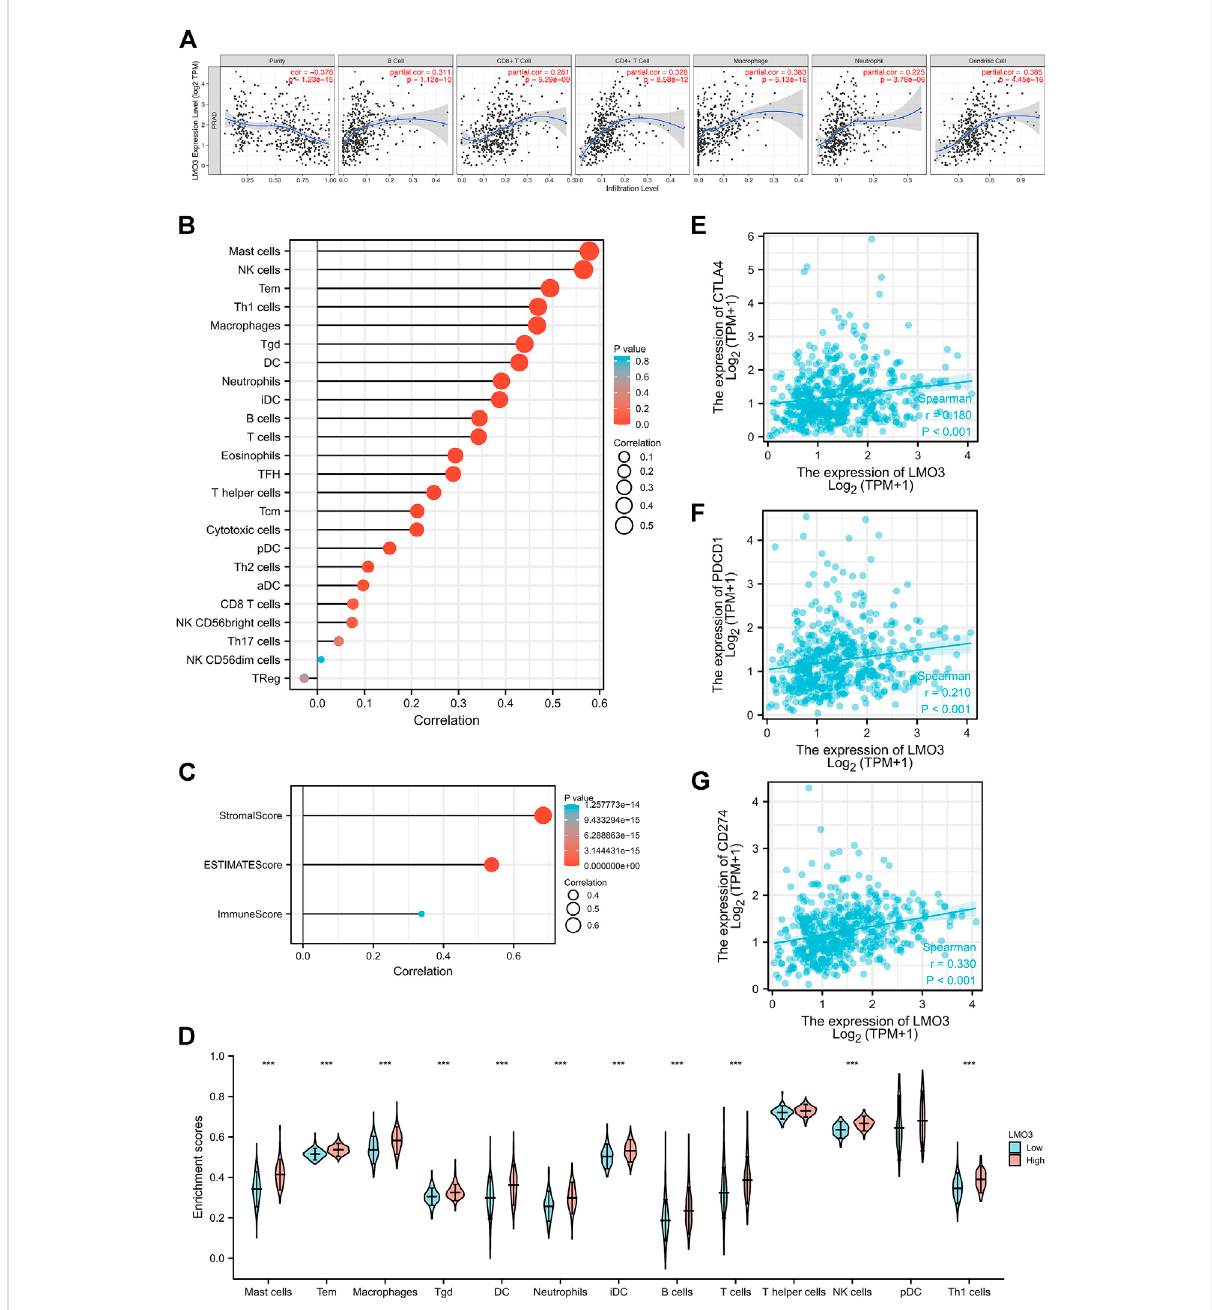
FIGURE 6 CorrelationofLMO3expressionwiththeimmunein fi ltrationlevel. (A) LMO3ispositivelycorrelatedwiththein fi ltrationofdifferentimmunecells using the TIMER database. LMO3 expression has a signi fi cant correlation with the in fi ltration of immune cells in prostate cancer by ssGSEA (B) and ESTIMATE (C) . (D) Subgroup analyses demonstrated that 11 kinds of immune cells were positively correlated with the expression of LMO3. (E – G) Scatterplots of the correlations between LMO3 expression and PD-1, PD-L1, and CTLA-4 in